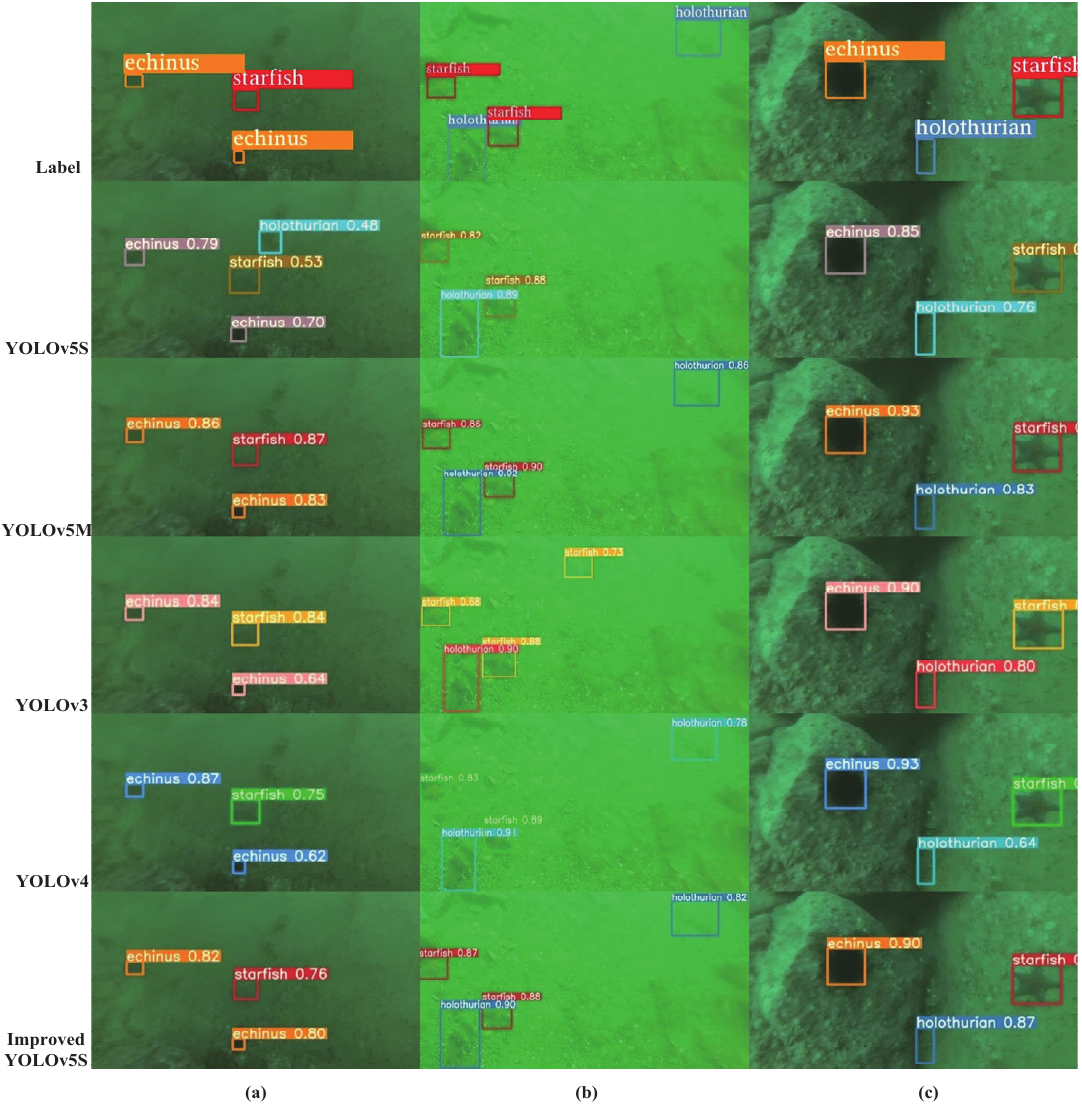
Figure 9. Comparison of test results of various models. ( a – c ) are three images with obvious contrast